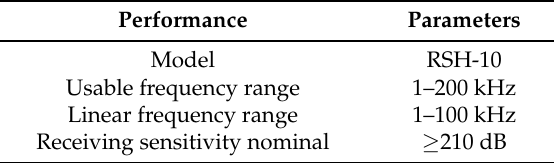
Table 2. Main specifications of the